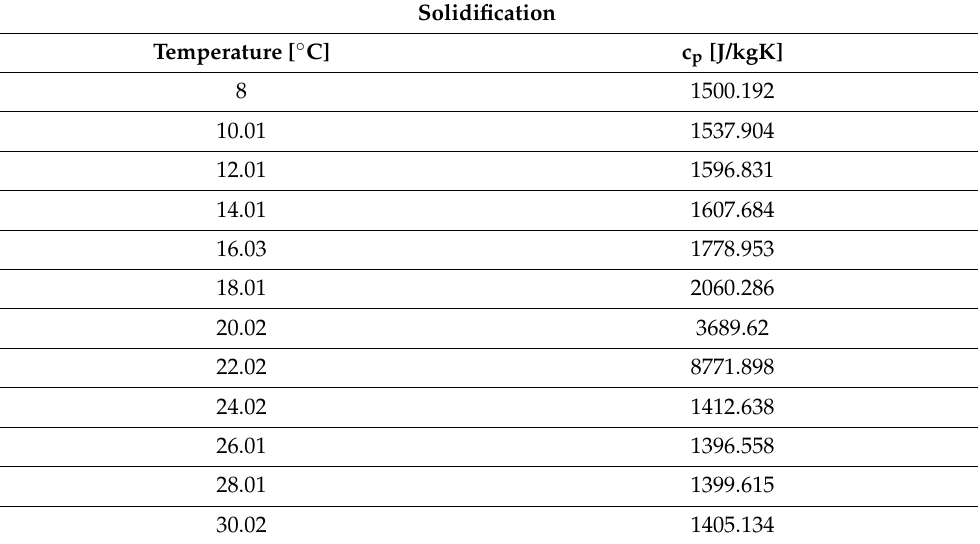
Figure 3. Mass thermal capacity of Micronal ® PCM SmartBoard™ 23, cooling stage: 30–8 °C.